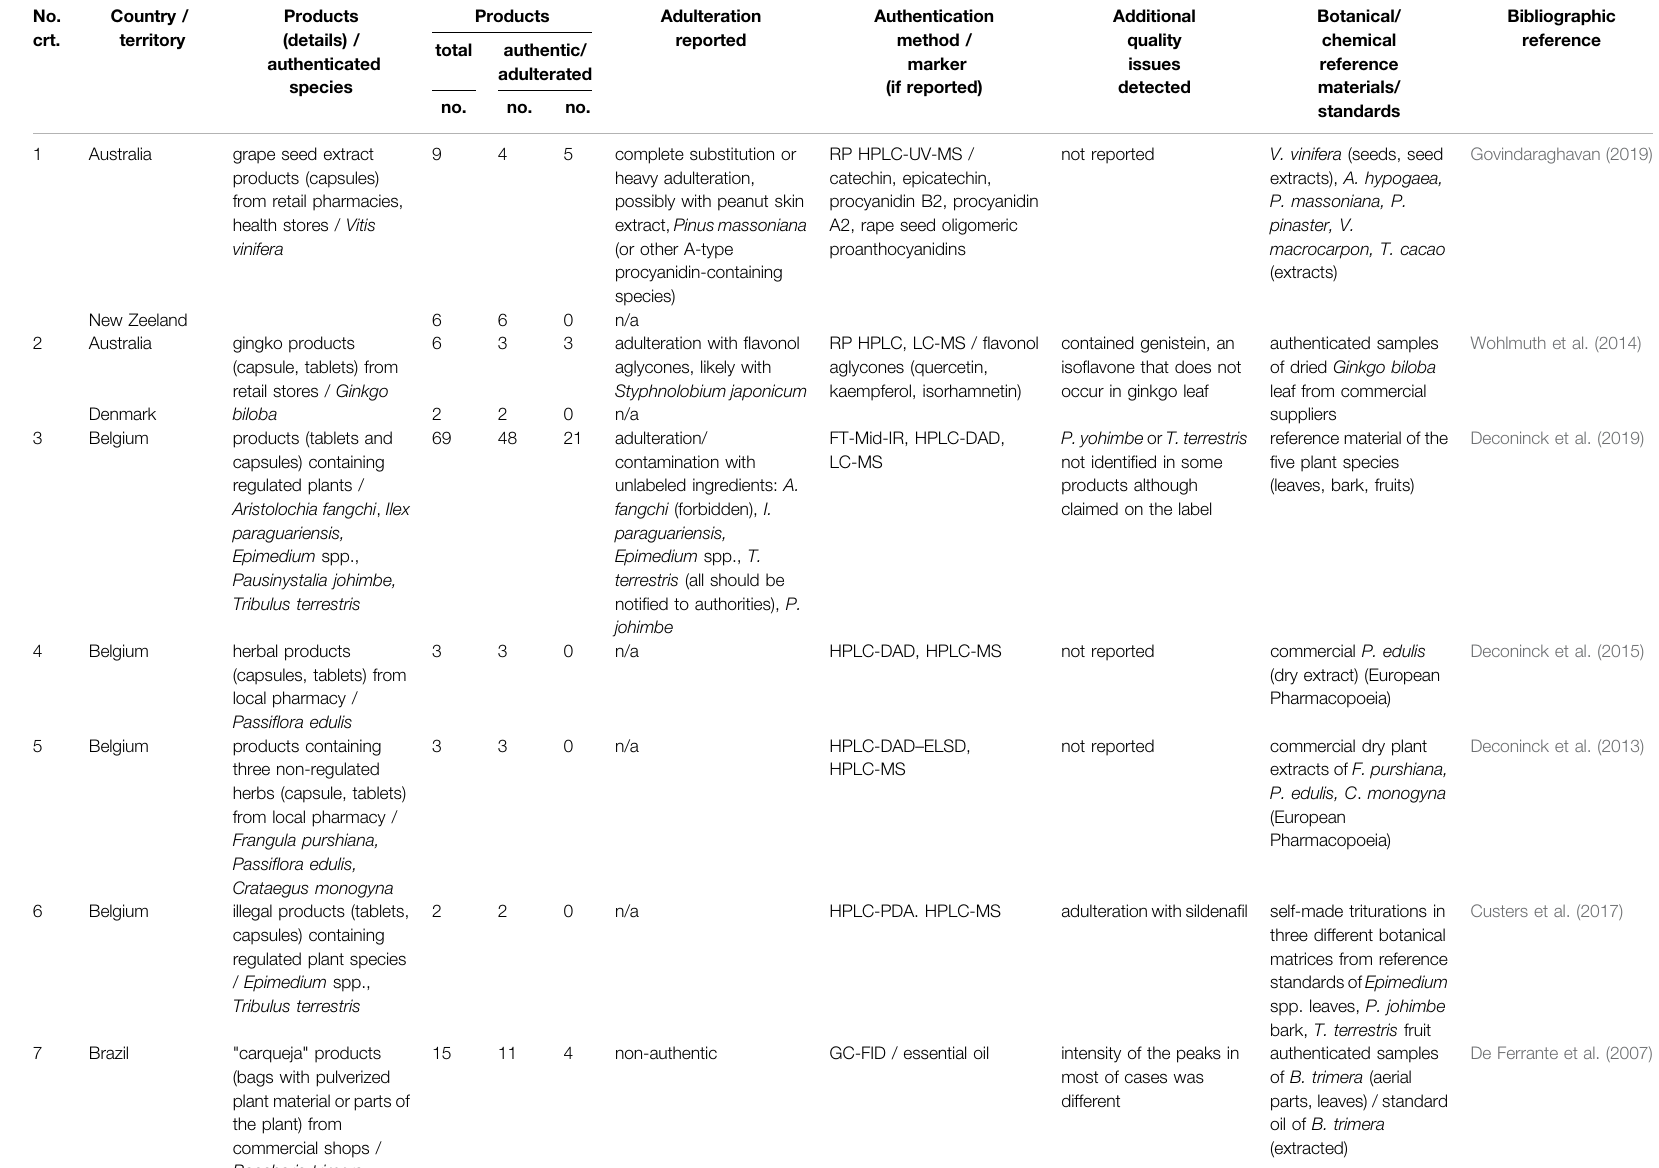
TABLE 1 | The authenticity of the chemically authenticated commercial herbal products at global level. No.